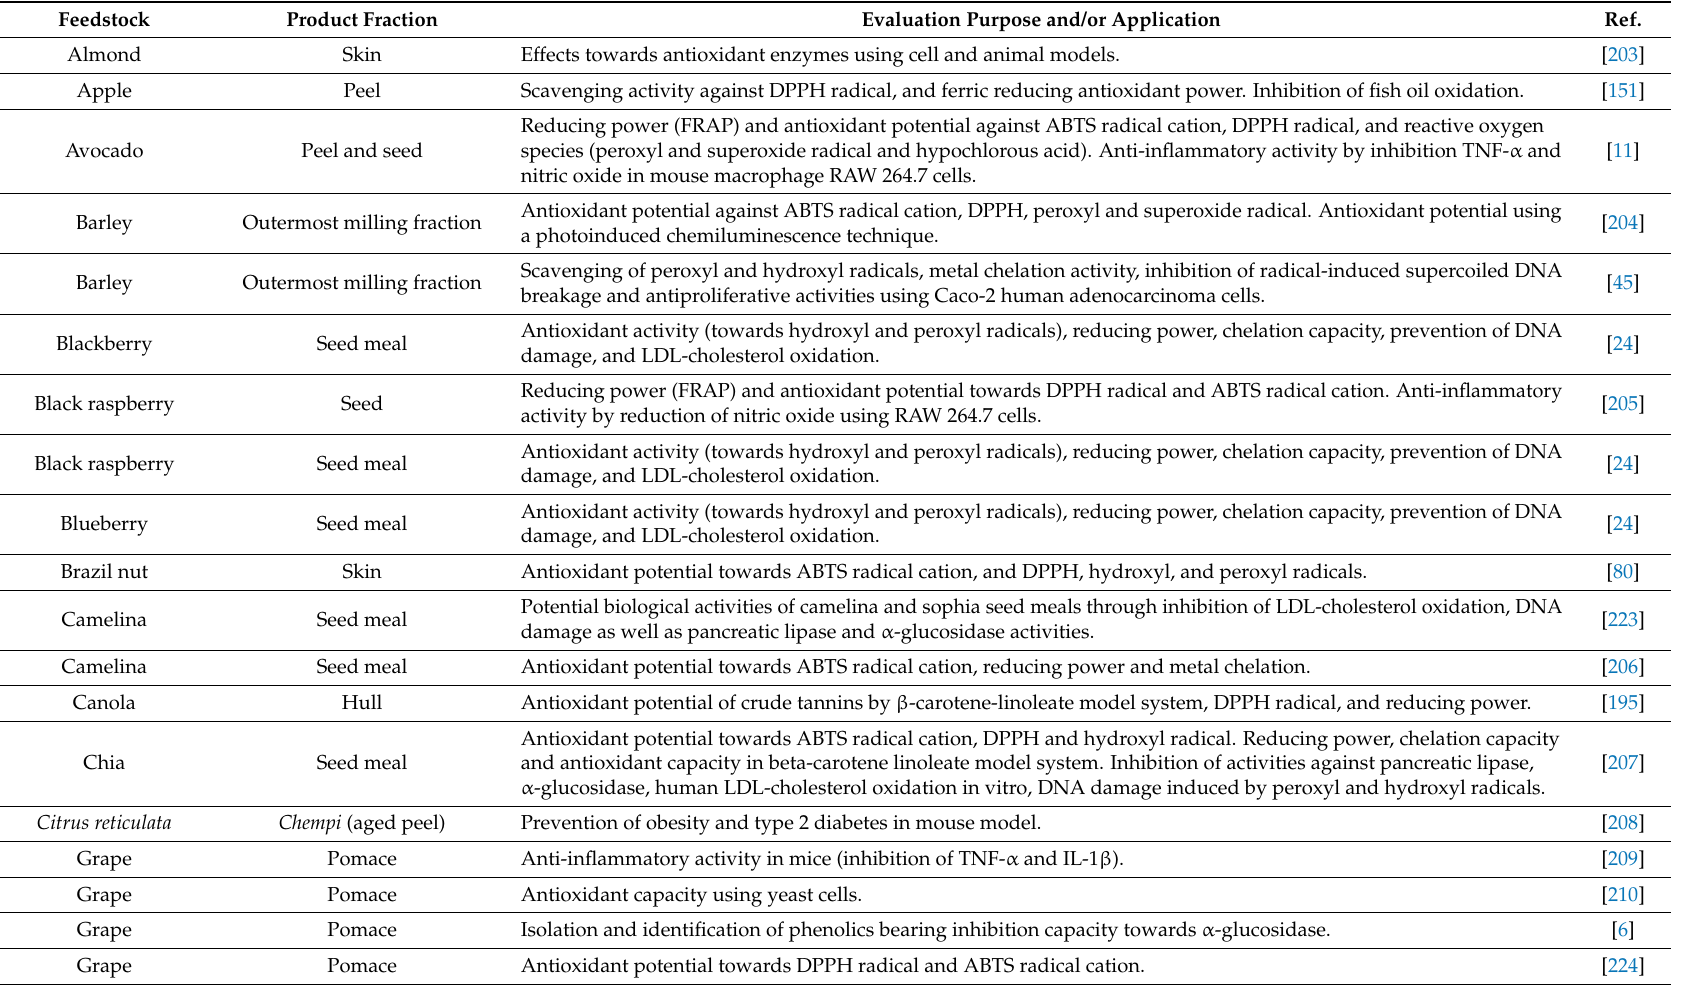
Table 3. Selected plant food by-products, screening and proposed